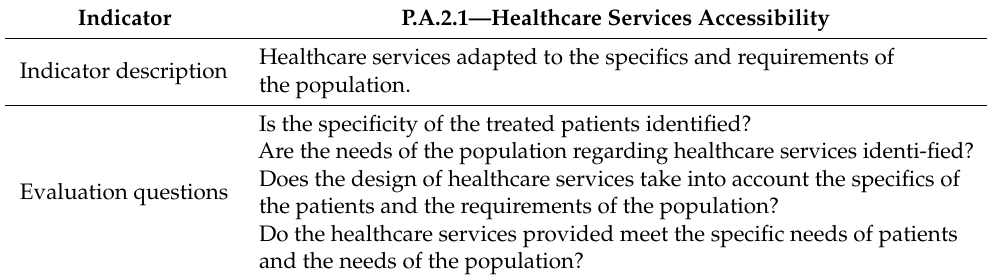
Table 3. The indicator P.A.2.1—Healthcare services accessibility.